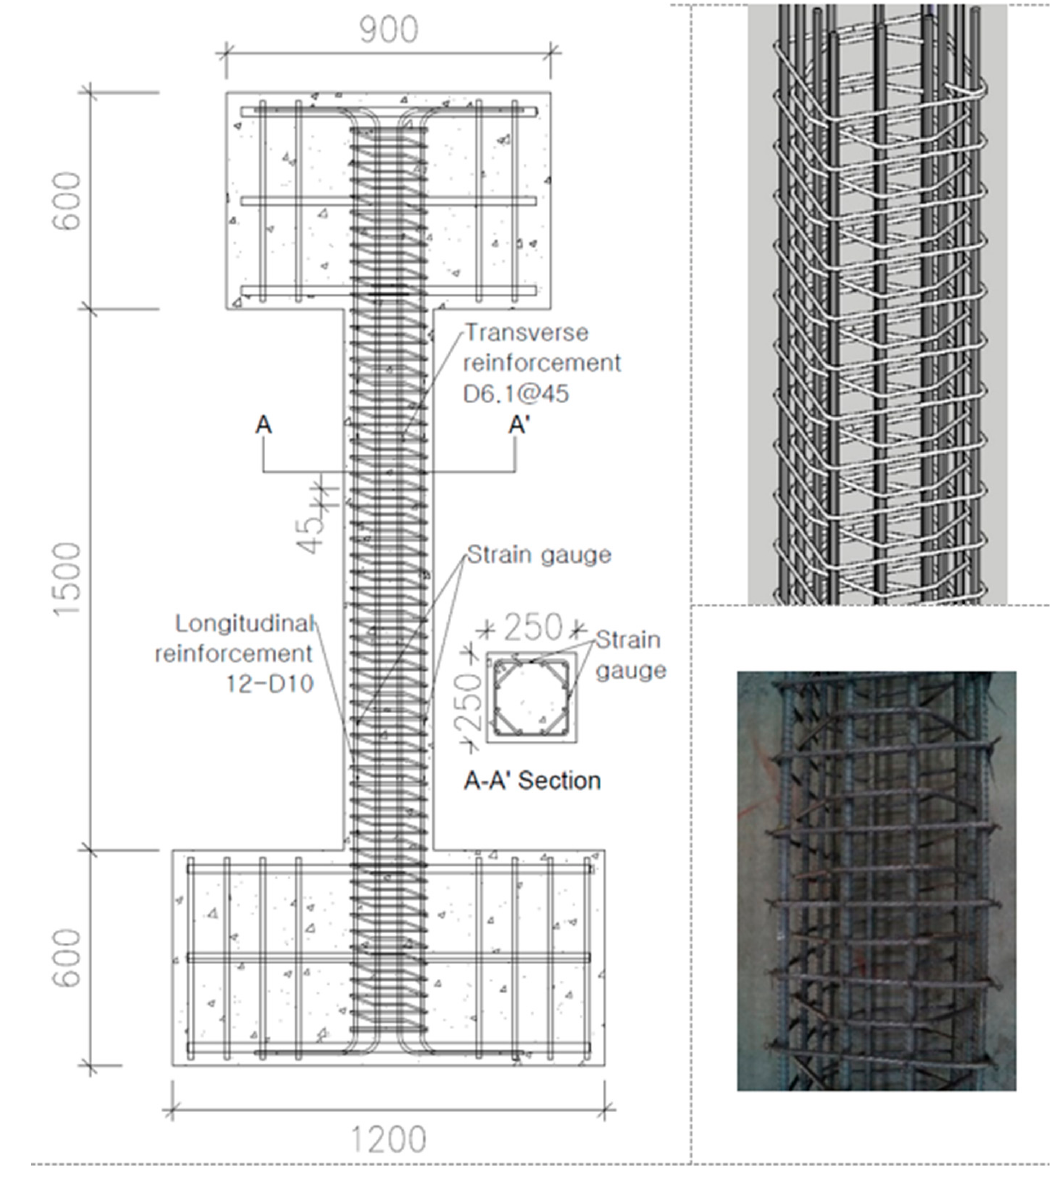
Figure 1. Details of specimens: ( a ) H-series; ( b ) S-series (1 mm = 0.0394 in.). Table 1. Properties of specimens (1 MPa = 145 psi, 1 mm = 0.0394 in.).